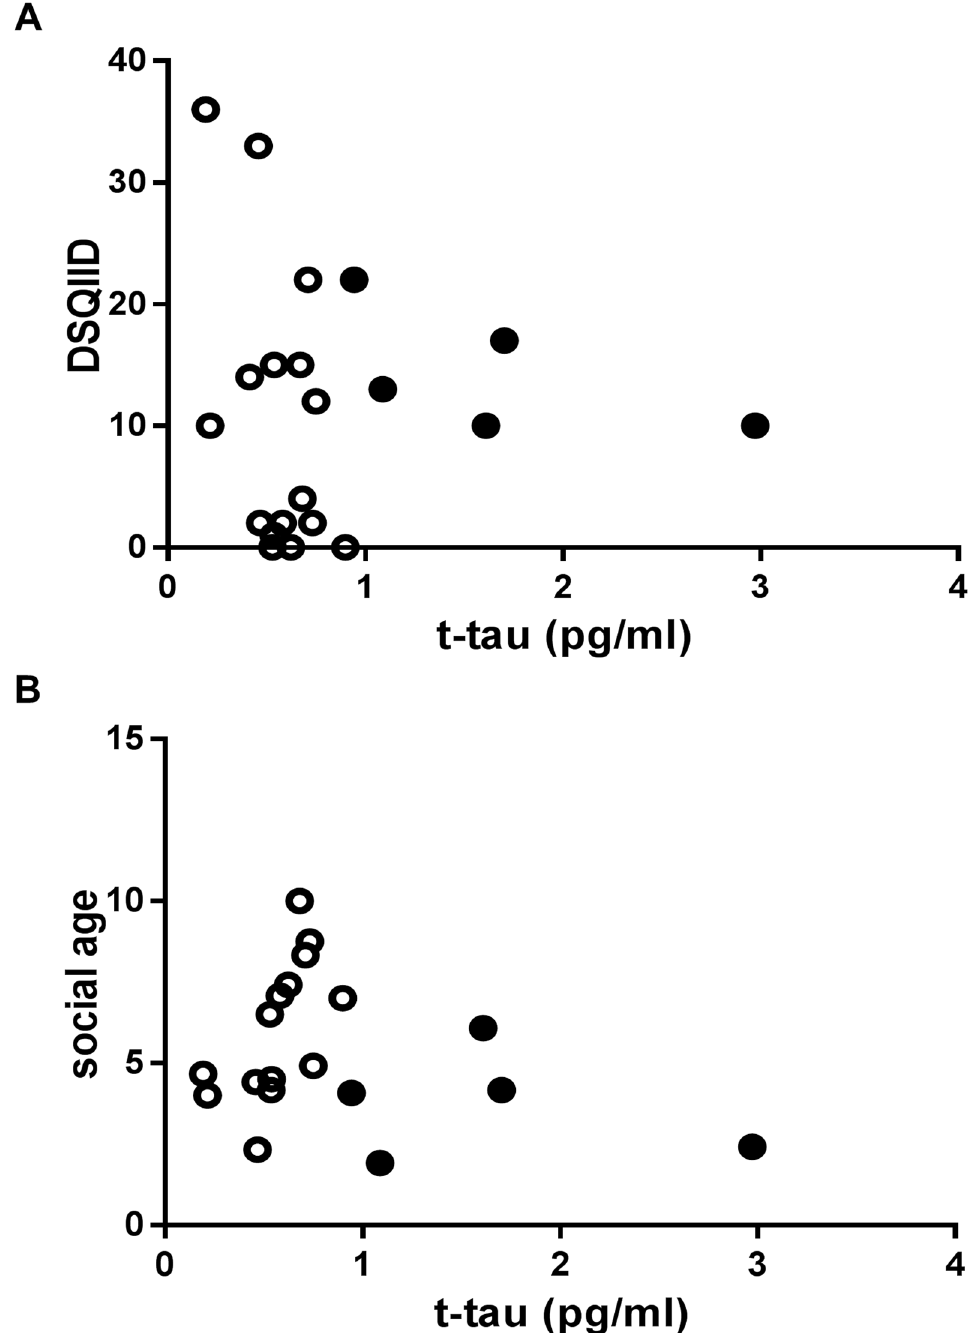
Fig 3. Correlation between t-tau levels and DSQIID score in the DS group(A) and between t-tau levels and social age in the DS group (B). There was no significantrelationship.The P value obtainedfrom Spearman’s rank correlationcoefficient test was 0.917 in (A) and 0.660 in (B). Filled circles (black) indicatethe DS cases with t-tau levels exceedingthe cut-off value (0.934 pg/ml indicatedby a dotted horizontalline), estimated from the control